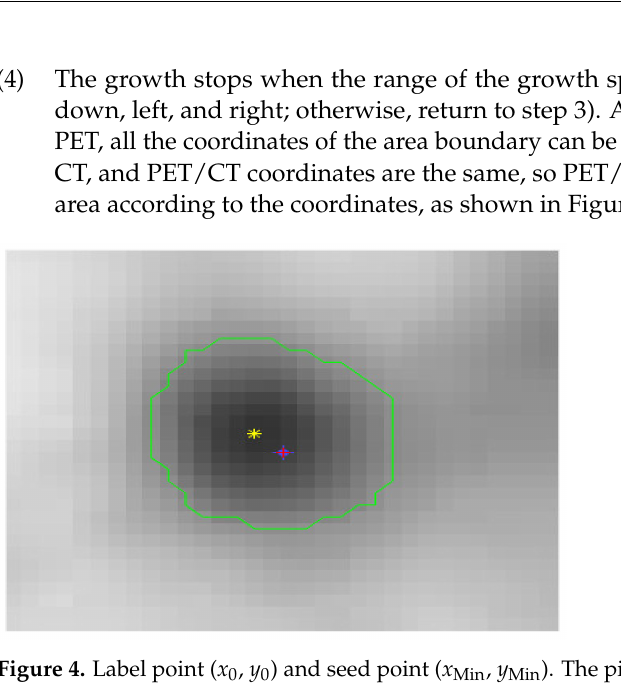
Figure 4. Label point ( x 0 , y 0 ) and seed point ( x Min , y Min ). The pink plus is the label point, the yellow star is the seed point, and the green line is the boundary line of the lesion after regional growth.